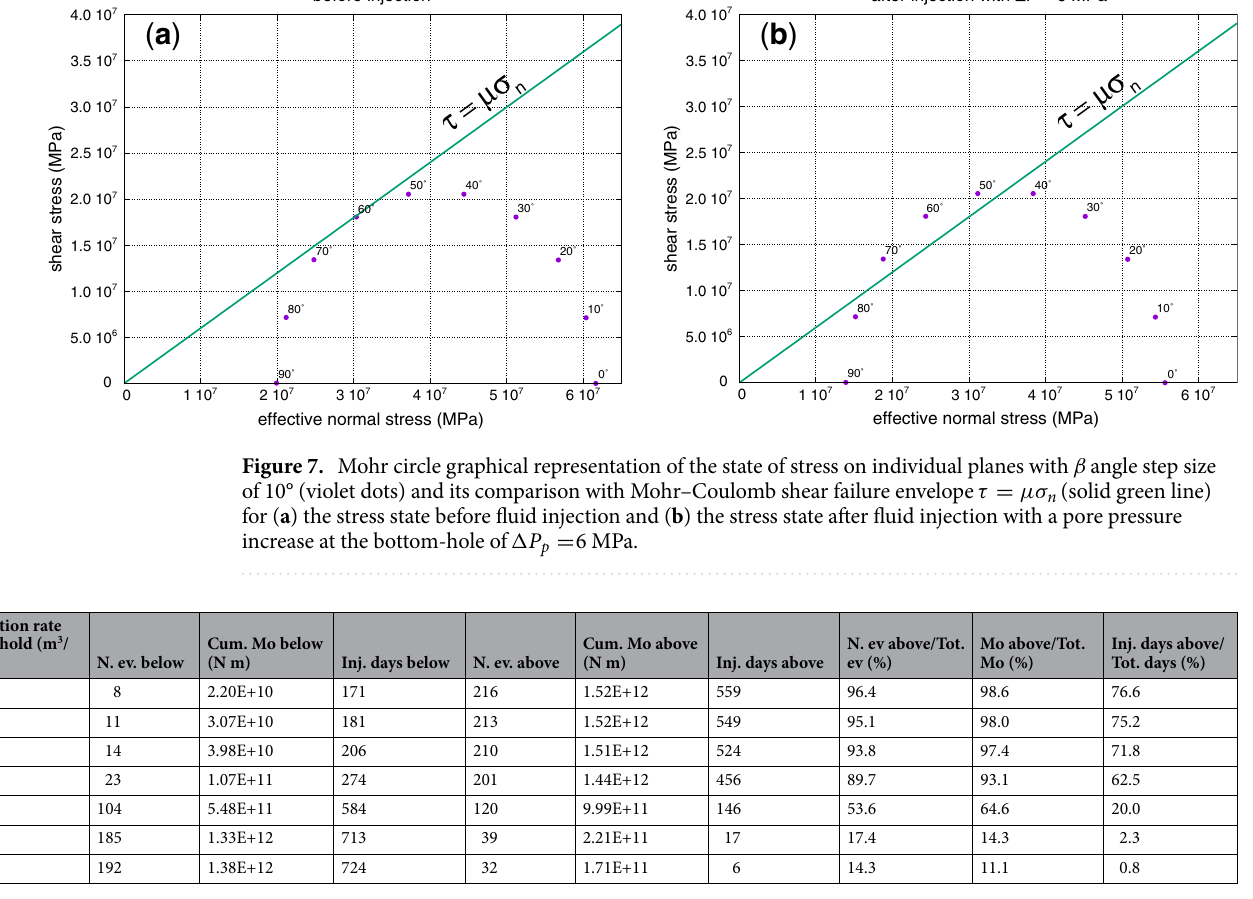
Table 1. Number of events (including those only detected), cumulative seismic moment of located events, and injection days below and above a given injection rate threshold. The last three columns also indicate the percentage of the number of events, the cumulative seismic moment, and the injection days above the given threshold out of the respective